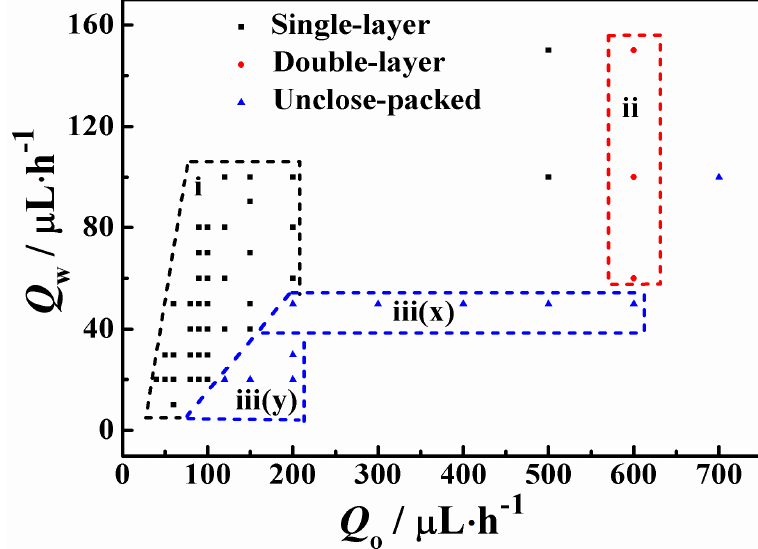
Figure 6. Diagram of the microdroplets assembly configurations as a function of two phase flow rates. The configurations were divided into: (i) close-packed well-ordered single-layer configurations, (ii) close-packed highly-ordered double-layer configurations and (iii) unclose-packed (loose or random) configurations. The microdroplets were generated in either dripping or jetting region at different flow rates. The dimensions of the flow-focusing microfluidic device were: w f = 25 μ m, d c = 40 μ m and W a = 400 μ m. Hexadecane with 2.7% ( w/v ) Span 80 and DI water were used as the oil phase and water phase, respectively.